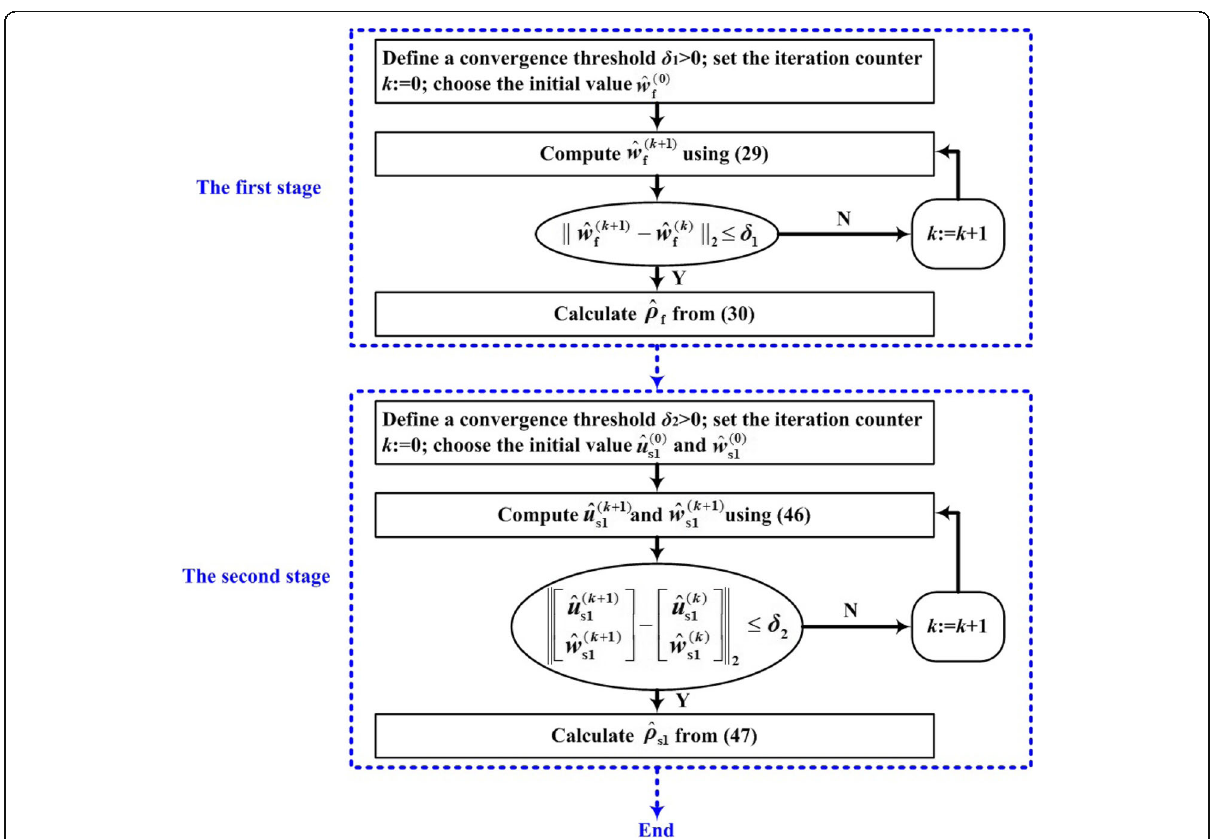
Fig. 2 Logical flowchart of algorithm